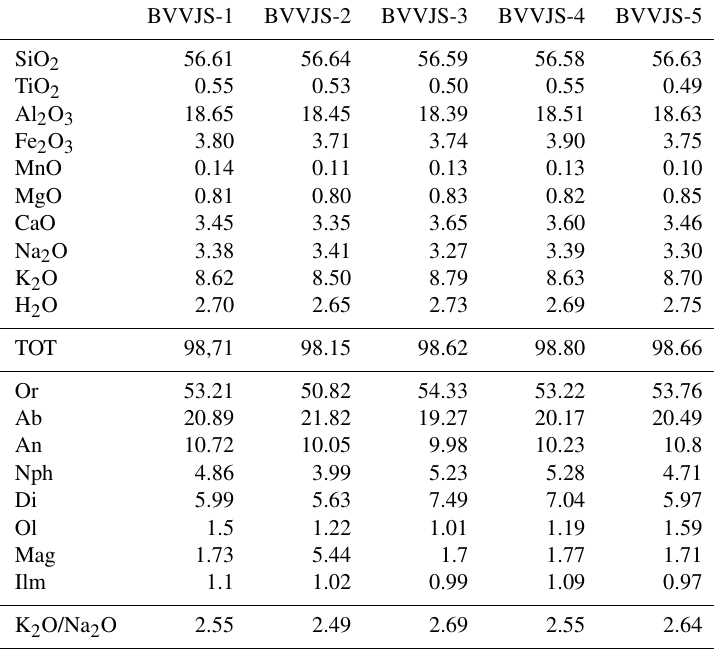
Table 2. Chemical analyses of BVVJS (wt% for major elements); 1–2: Tufitalia quarry, location Civita Castellana; 3: La Bannita quarry, location Castel S. Elia; 4–5: Monte del Tempio quarry, location Sutri. CIPW values are reported for graphical representation. Mineral abbreviations as reported in Whitney and Evans (2010).